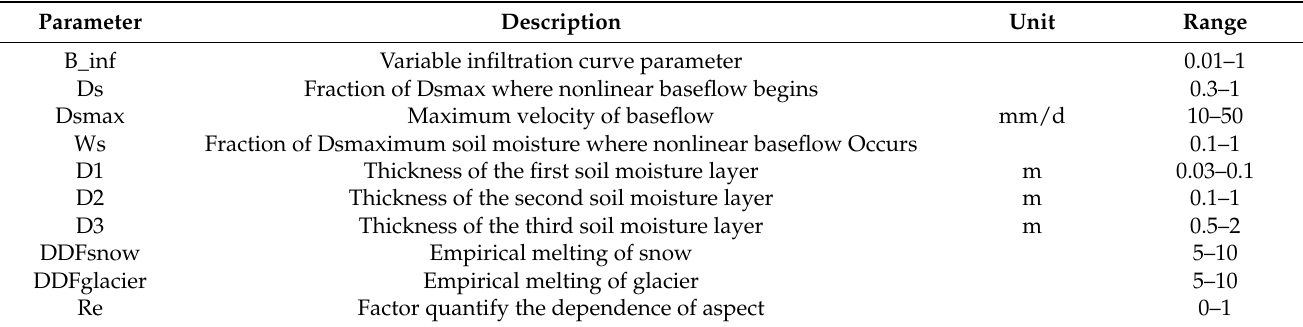
Table 2. Basic parameters for the VIC–Glacier